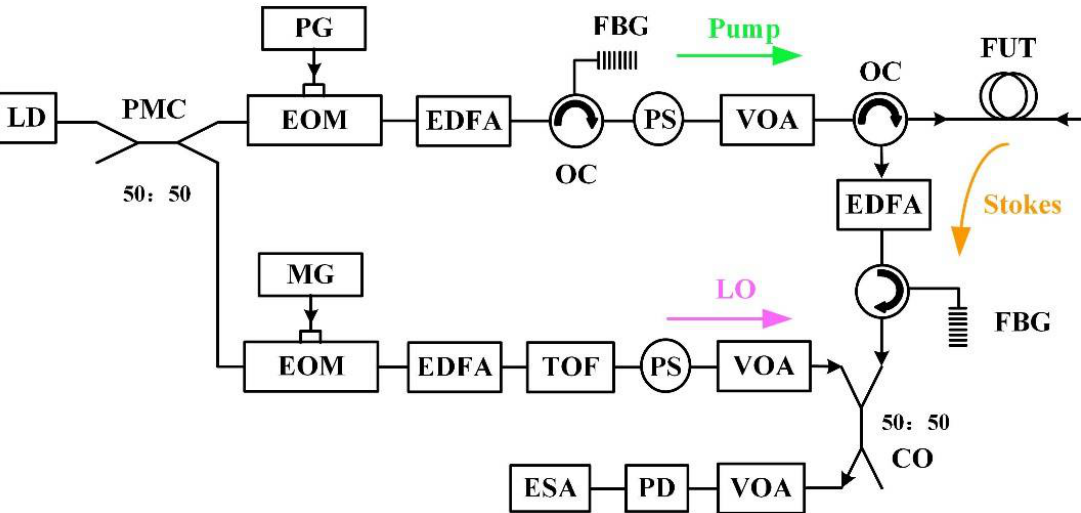
Figure 5. Experimental setup of BOTDR. PMC: polarization-maintaining coupler; PG: pulse generator; EOM: electro-optic modulator; EDFA: erbium-doped fiber amplifier; FBG: fiber Bragg grating; PS: polarization scrambler; MG: microwave generator; TOF: tunable optical filter; CO: coupler; PD: photoelectric detector; ESA: electrical spectrum analyzer.